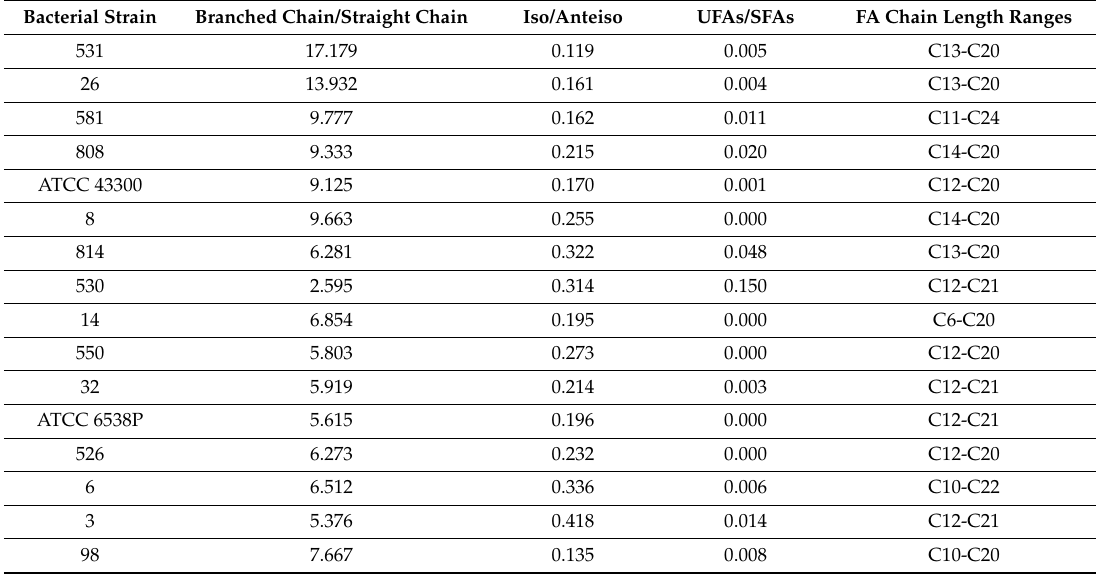
Table 2. Features of lipid profiling identified in the selected bacterial